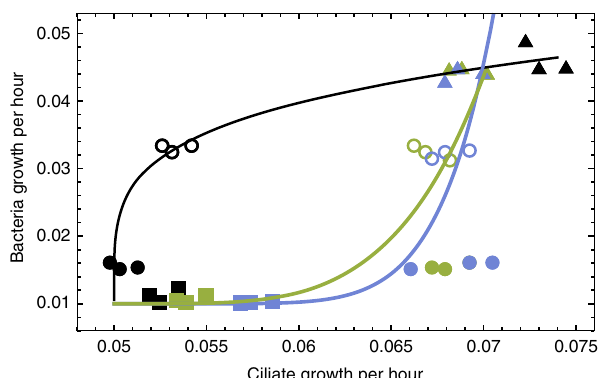
Fig. 2 Growth-defense trade-off curves evolve from concave to convex in coevolving microbial predator – prey systems. Colors are associated to different ciliate populations and symbols to different bacteria populations. The growth and defense of four bacteria populations were measured in the presence of ancestral naive ciliates (black) and two independently coevolved ciliate populations (green coevo1 and blue coevo2). Bacteria defense is shown as cilliate growth rate in the x -axis, where lower ciliate growth rates indicate higher bacteria defense. The triangles represent the ancestor bacteria population, which has the highest growth. The three coevolved bacteria populations are respectively shown by hollow circles, fi lled circles and squares, and they differ in growth (their values in y -axis). In the ancestral ciliates, a concave trade-off curve was selected (non-linear least squares fi tting, black curve, R 2 = 0.999), and in coevolved ciliate populations convex trade-off curves were selected (nonlinear least squares fi tting, green curve R 2 = 0.997 and blue curve R 2 = 0.998) NATURE COMMUNICATIONS | 8: 2059 | DOI: 10.1038/s41467-017-01957-8 |